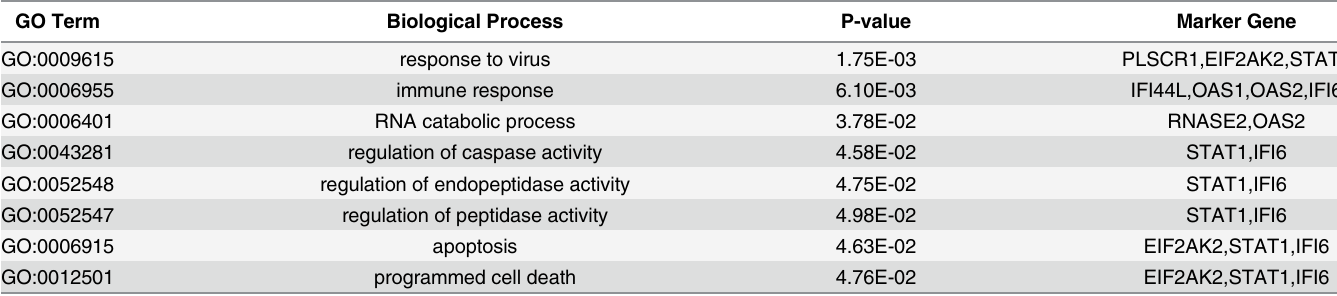
The top significant enriched biological processes, for the 10 common genes identified above for SLE, were shown in Table 3 . The most significantly enriched functions were “ response to virus ” Table 3. The Significantly Enriched GO Terms of Biological Processes for the Ten Common Marker Genes